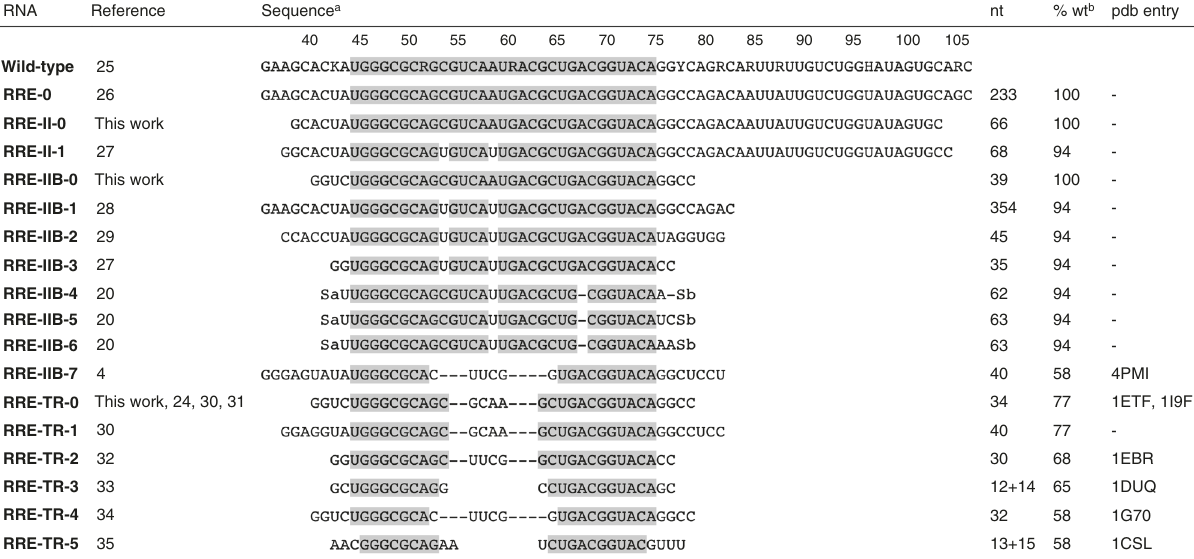
Fig. 1 RRE II RNA constructs used in this work (RRE-II-0, RRE-IIB-0, RRE-TR-0) and in previous studies. a From 5 ′ -OH- to 3 ′ -OH-terminus; R = G or A , K = G or U , Y = C or U , H = A , C , or U ; Sa and Sb stand for complementary, 15 nt RNA segments designed to form an arti fi cial stem structure 20 (not counted in %wt), and nucleotides of stem IIB that are conserved between consensus sequences from each of the major families of HIV-1 25 are highlighted in gray, b sequence similarity to the 45 – 75 region of wild-type RRE